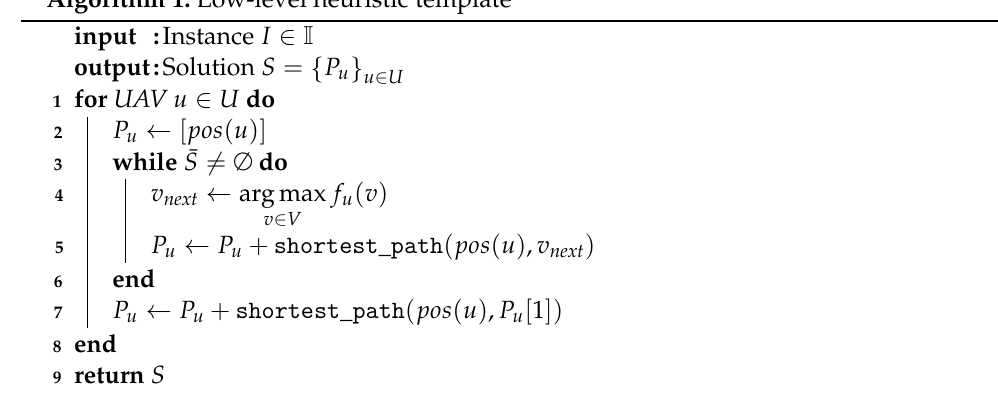
Algorithm 1: Low-level heuristic